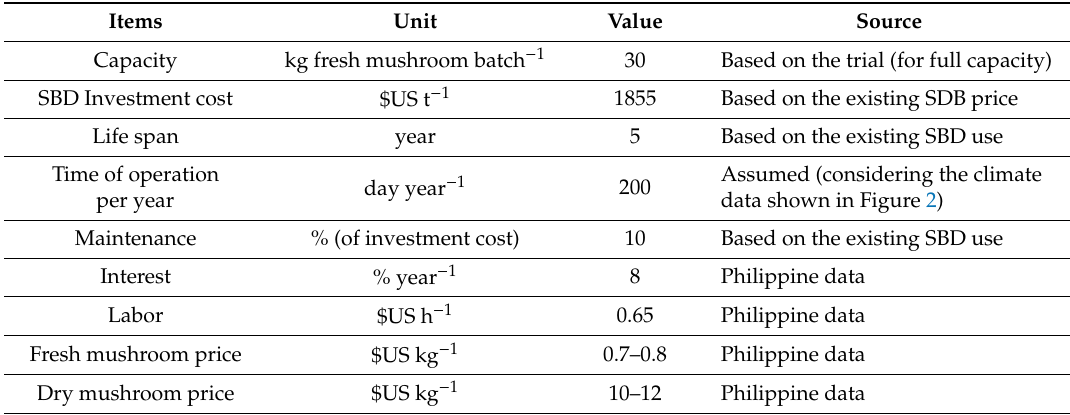
Table 3. Parameters for cost-benefits